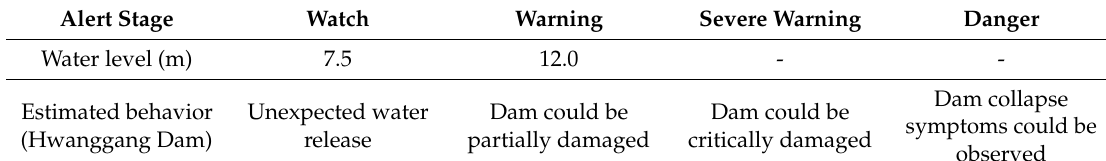
Table 2. Alert stages for the downstream Imjin River using the water levels at Hoengsan [16].